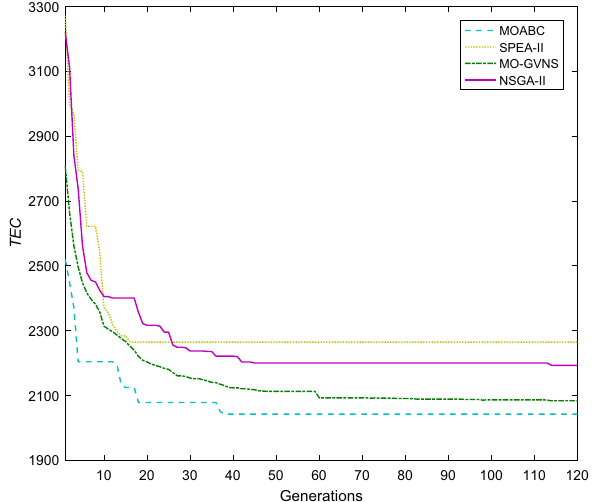
Figure 18. Convergence diagram of instance f2j15s3r1 about C max .